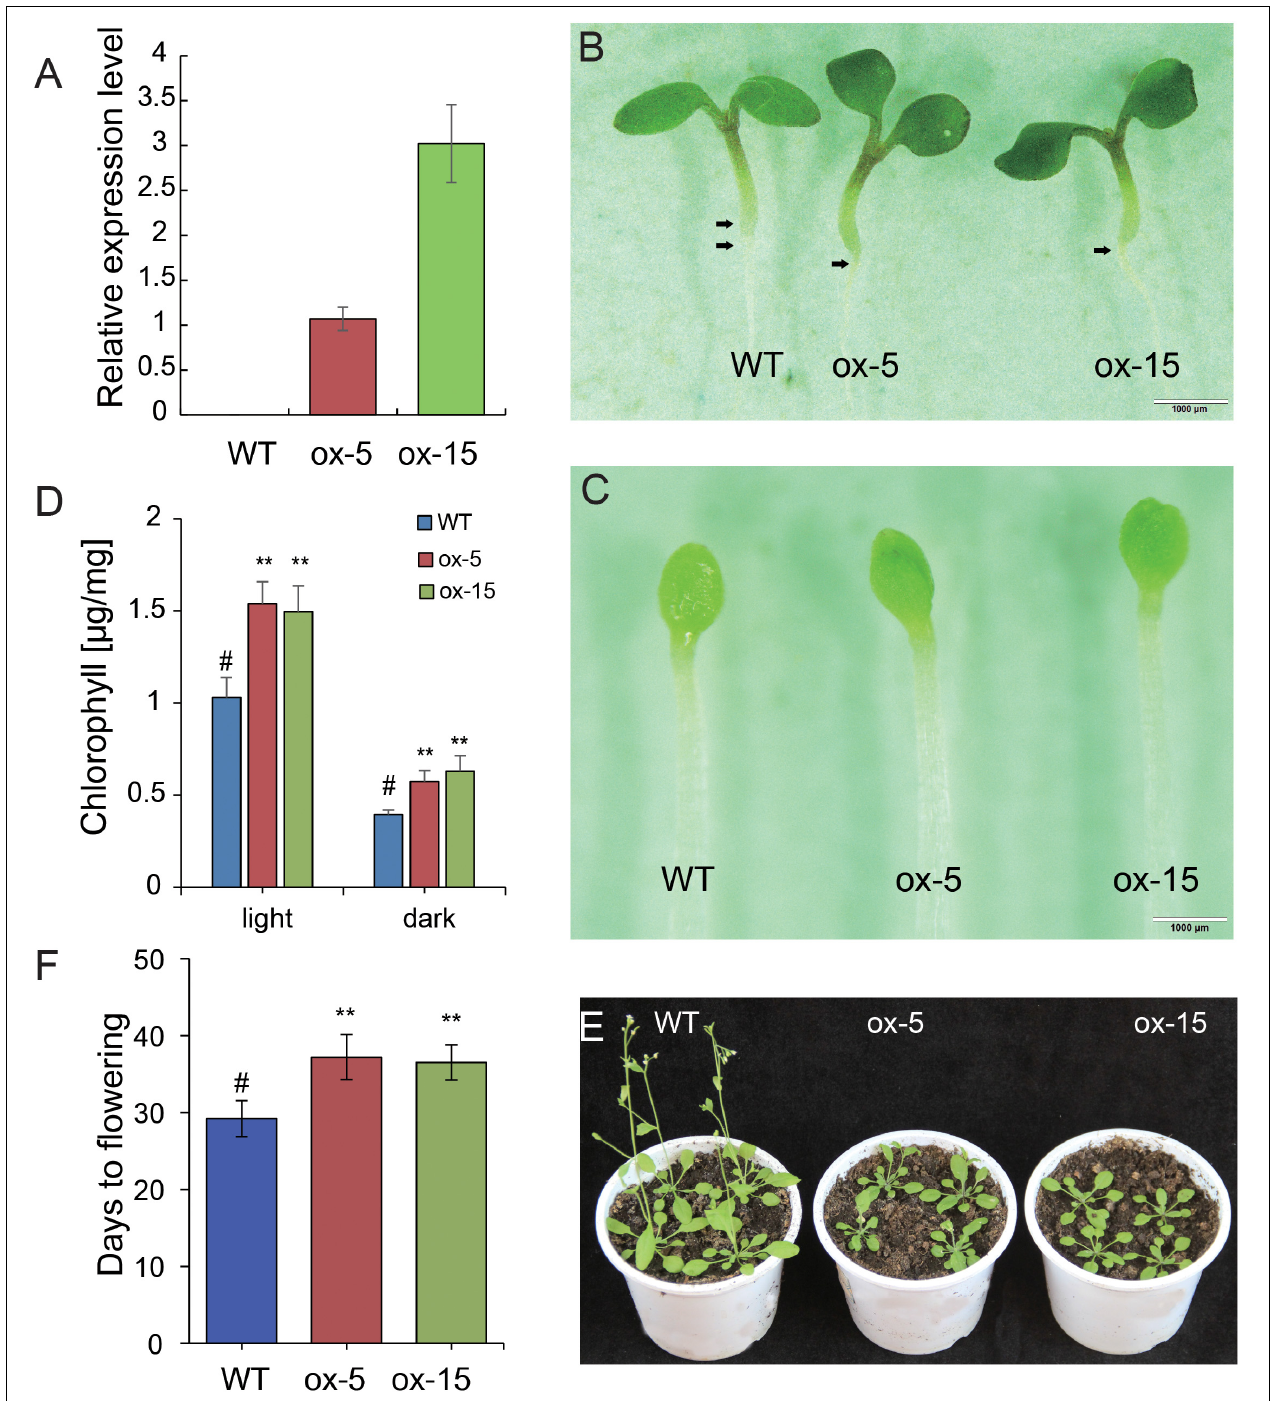
FIGURE 7 | Effects of the ectopic expression of BdGATA13 on greening and flowering in transgenic Arabidopsis . (A) Relative expression levels of two transgenic lines by qRT-PCR, N.D., not detected. (B) Phenotype of the WT and the two transgenic lines in 5-day-old seedlings grown under long-day conditions, bar = 1 mm. (C) Phenotypes of 5-day-old WT and two transgenic lines grown in darkness, bar = 1 mm. (D) Average and standard deviations of chlorophyll levels of WT and transgenic plants grown for 5 days in light or darkness (three biological replications). (E) Flowering time comparison of WT and transgenic lines grown in long-day conditions. (F) Comparison of days to flowering for WT and transgenic plants. Values are means ± SD ( n = 3). Asterisks represent statistically significant differences between the indicated samples. Student’s t -test: * P ≤ 0.05, ** P ≤ 0.01.